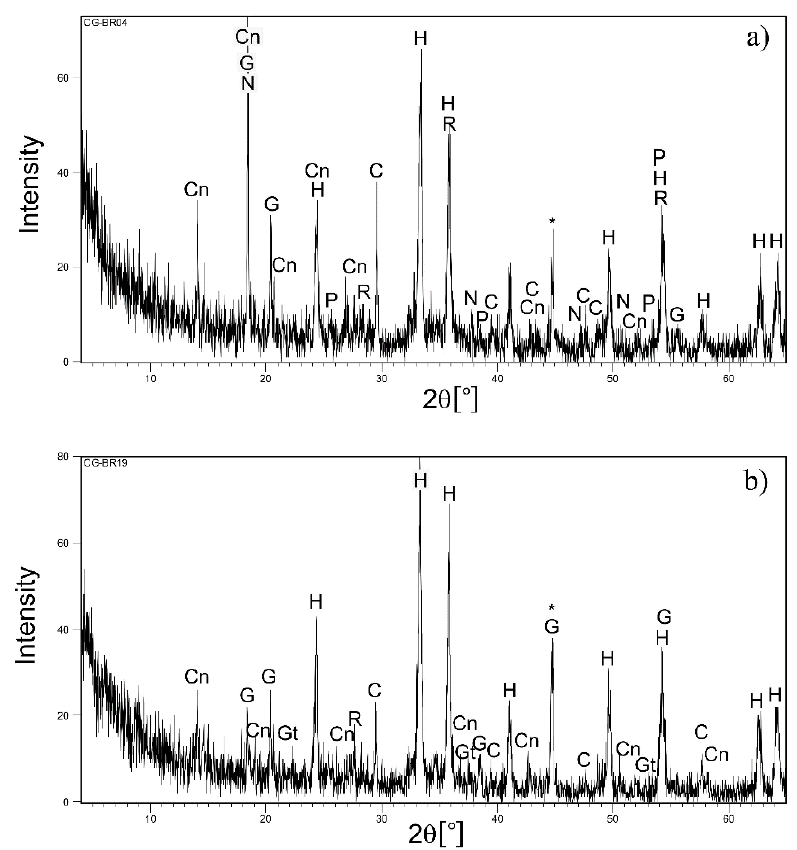
Figure 6. XRD patterns of two typical analysed samples from Gernjepoljski vir deposit: ( a ) upper part and ( b ) middle part of deposit (B—böhmite, G—gibbsite, D—dolomite, A—anatase, Gt—goethite, K—kaolinite, V—vermiculite, *—Al-sample holder) (REEBAUX project documentation, Tomaši ć [6]).